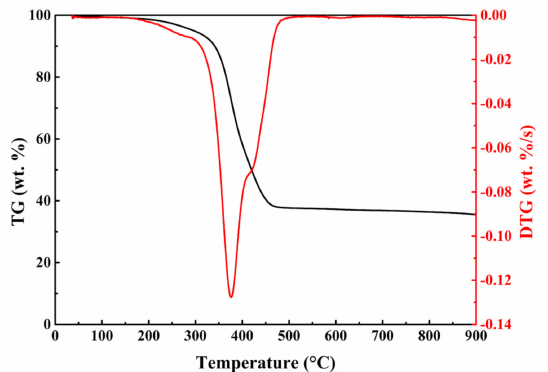
Figure 2. TG and DTG curves of WT pyrolysis without catalysts at the heating rate of 10 ◦ C/min.